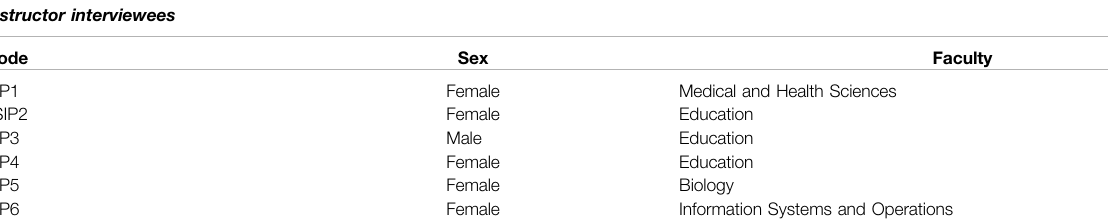
TABLE 1 | Participant characteristics.